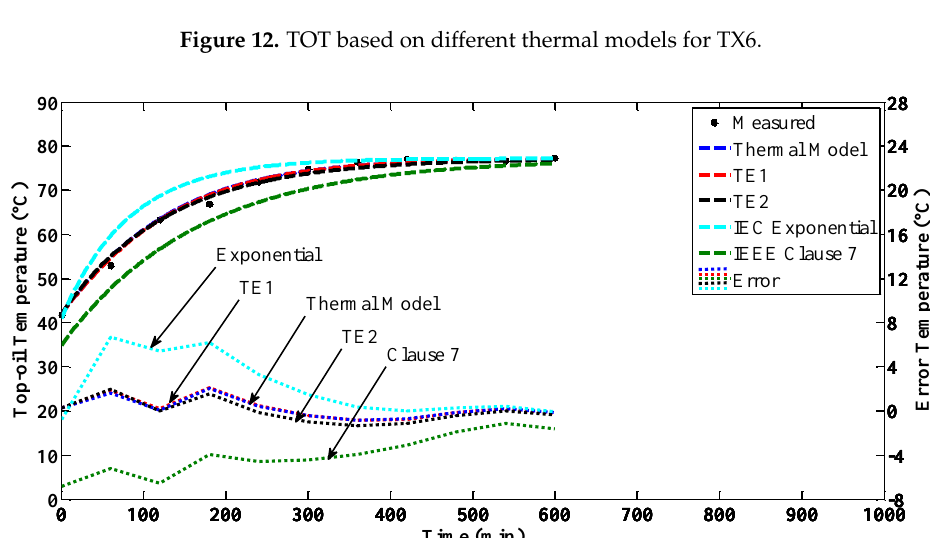
Figure 13. TOT based on different thermal models for TX7.